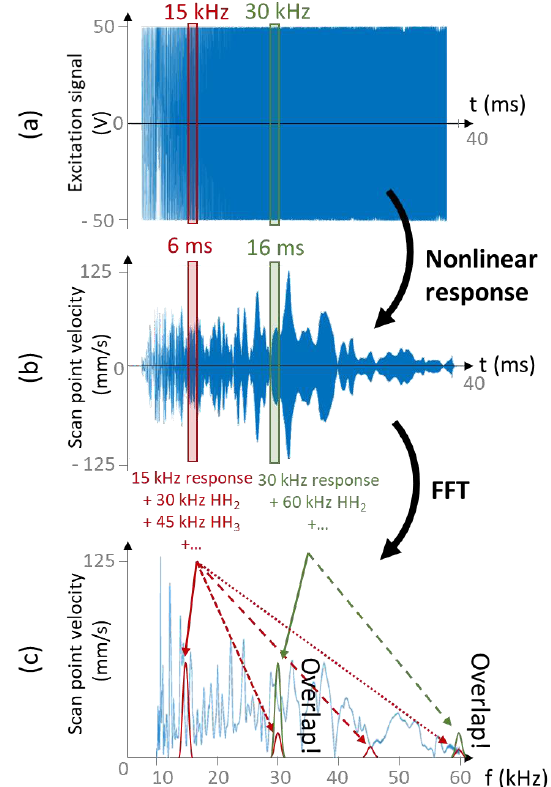
Figure 3. ( a ) Burst chirp excitation signal in time domain, ( b , c ) velocity response in time and frequency domain (using fast Fourier transformation (FFT)), respectively.